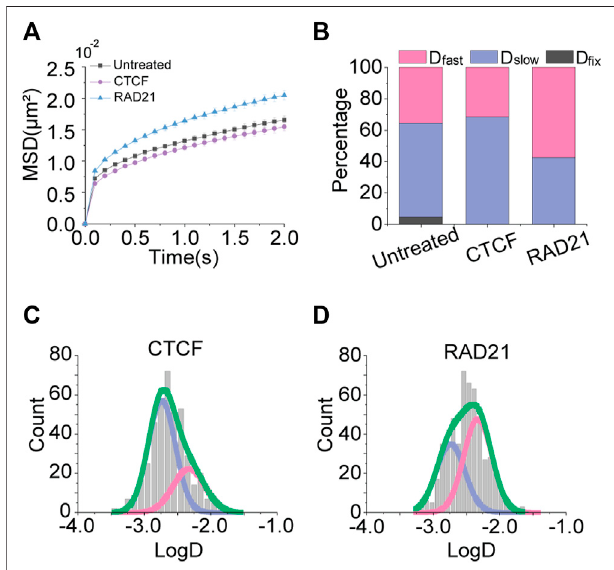
FIGURE 5 | Effects of chromatin architectural protein overexpression. (A) Averaged MSD-t plots for each time interval under the normal condition and with overexpression of CTCF and RAD21. (CTCF, N = 32 cells, n = 449 trajectories;RAD21,N=45cells, n =566trajectories) (B) Percentagesof diffusion constant components from multimodal Gaussian fi ttings for each condition. (C,D) Distributionsofdiffusionconstantsforindividualtrajectoriesin cells treated with CTCF and RAD21 overexpression, respectively. Green lines represent fi tting with triple Gaussian peaks for the entire distribution. Pink and blue lines represent single Gaussian portions for fast and slow diffusions,